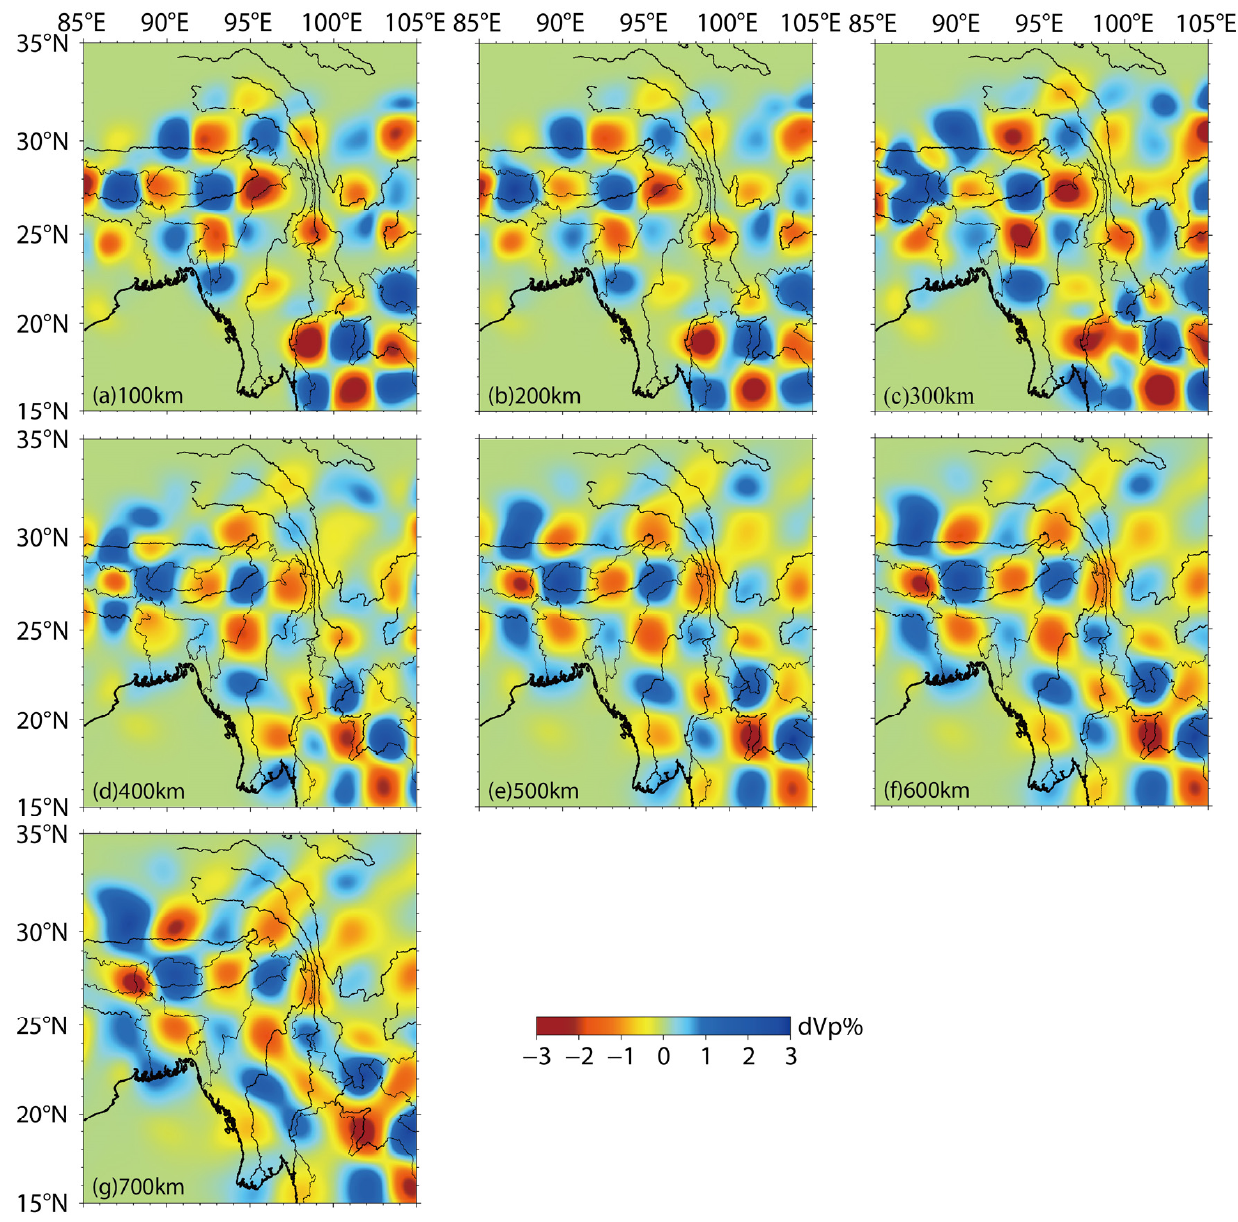
Figure 5. Checkerboard resolution test results of 0.7 ◦ × 0.7 ◦ × 85 km ( a – g